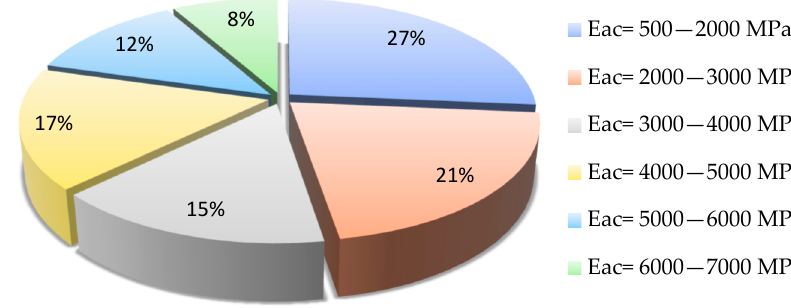
Figure 6. Percentage values of the number of E AC in the given ranges.